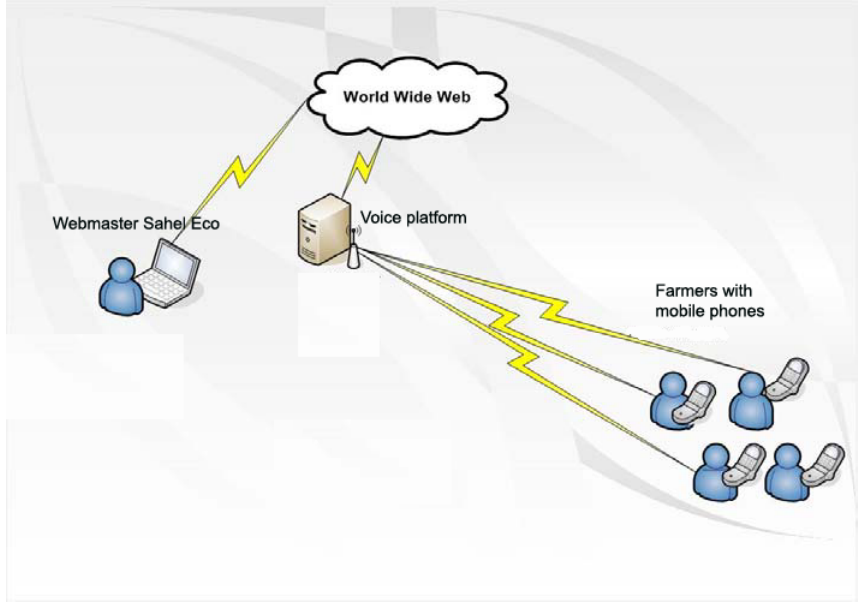
Figure 7. Network diagram of the Tabale system